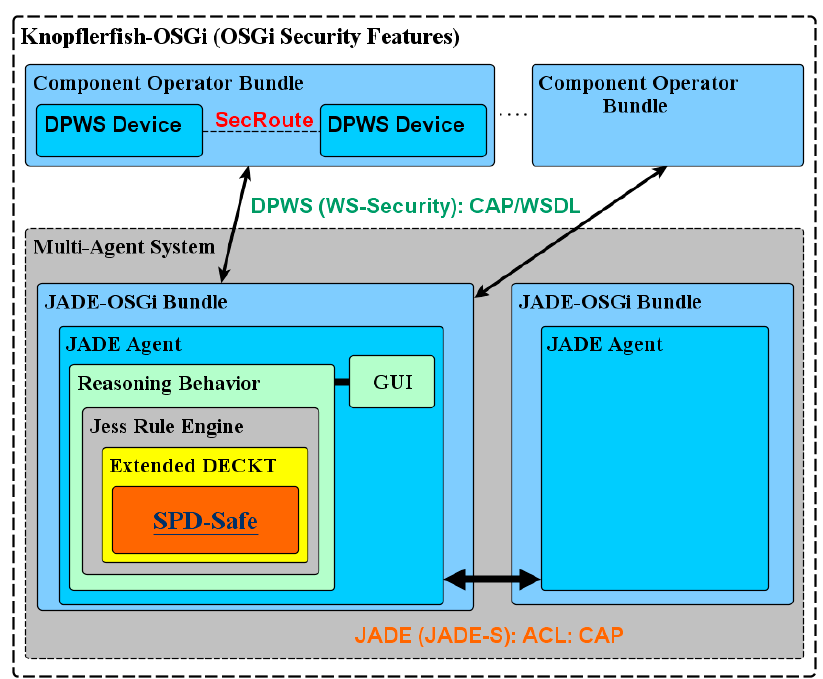
Figure 1. The software layers of the proposed security, privacy, and dependability (SPD)-Safe